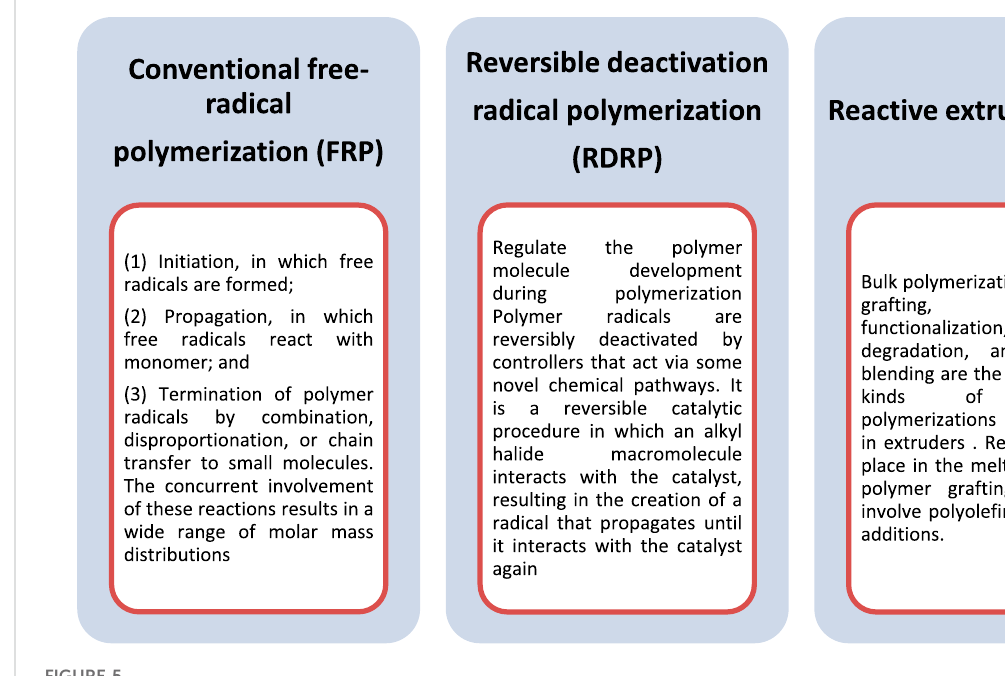
FIGURE 5 Types of Free-radical polymerization methods.